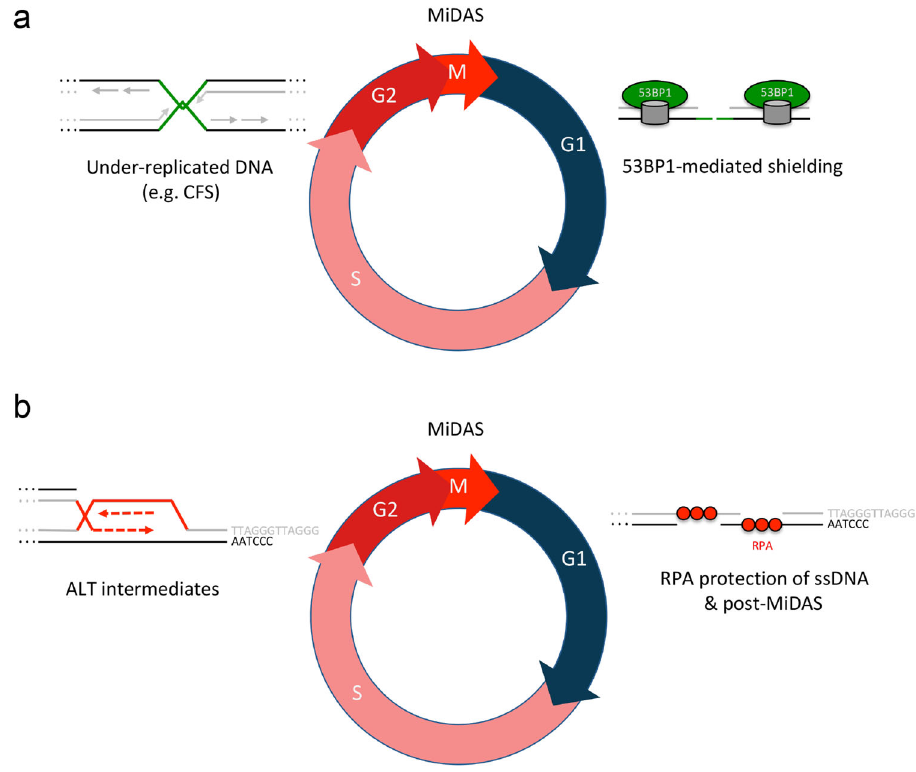
Fig. 7 Model of inherited ssDNA lesions at telomeres, shielded by RPA for post-MiDAS. a Under-replicated DNA, e.g., at common fragile sites (CFS), is transmitted from S/G2 to mitosis, giving rise to 53BP1 nuclear bodies in G1. b ssDNA lesions at chromosome ends, e.g., ALT intermediates, are